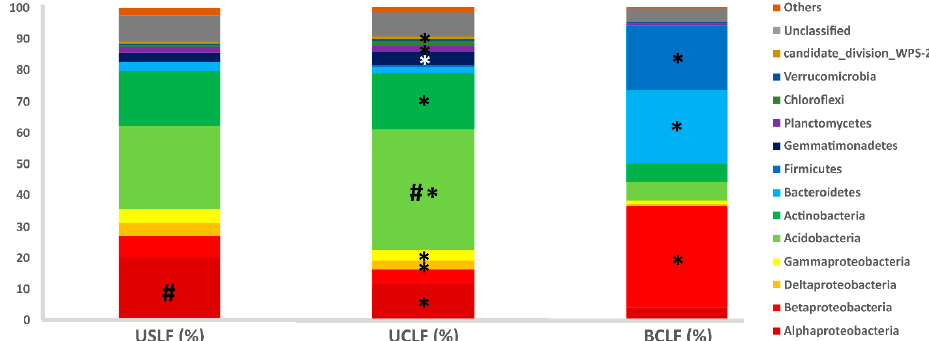
Figure 1. Relative abundance of the dominant bacterial phyla in undisturbed and burnt soils of the laurel forest at the Garajonay National Park. Comparison of two undisturbed forests, the slope and crest laurel forests (USLF and UCLF) and burnt crest forest (BCLF) areas. For phylum Proteobacteria, classes alpha, beta, and gamma are also shown. Phyla accounting for less than 0.7% relative abundance are included under ‘Others’. # and * refer to taxa with a significantly increased relative abundance in two to two comparisons. Statistically significant differences in the relative abundance are shown in Supplementary Figure S2.